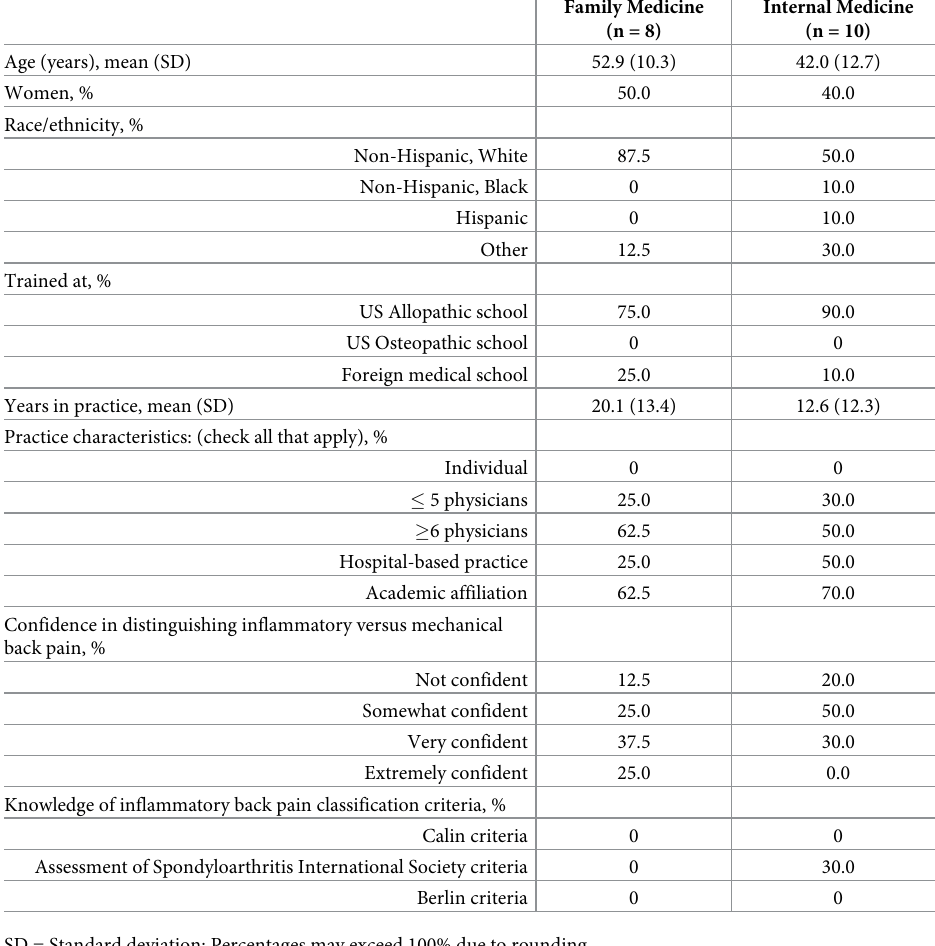
Table 1. Characteristics a of physician participants by